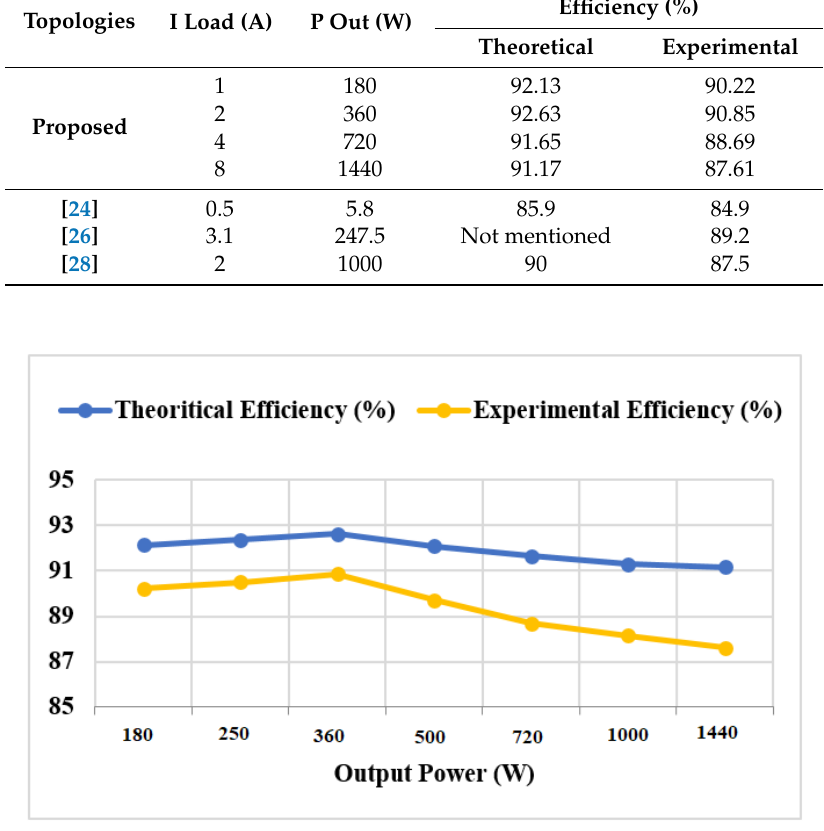
Table 3. Comparison of the proposed topology with other recently introduced ones in terms of efficiency.